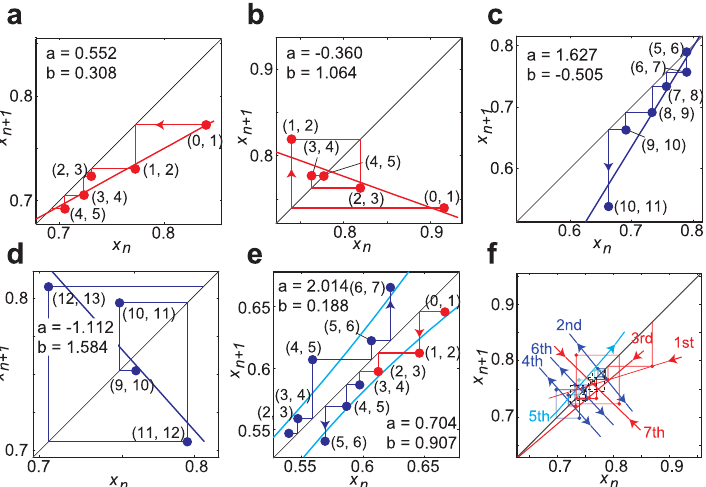
Figure 4. Examples of a well-fitted series of points by each function using the return map analysis. ( a – d ) Linear functions, X n + 1 = aX n + b , with four different slopes for 0 < a < 1, − 1 < a < 0,1 < a , and a < − 1, respectively. ( e ) Exponential function, X n + 1 = b exp ( aX n ) , and logarithmic function, X n + 1 = a log ( X n ) + b . ( f ) Examples of switching functions in one scene. The red lines show attractors, blue lines show repellers, and cyan lines show intermittencies. Modified from